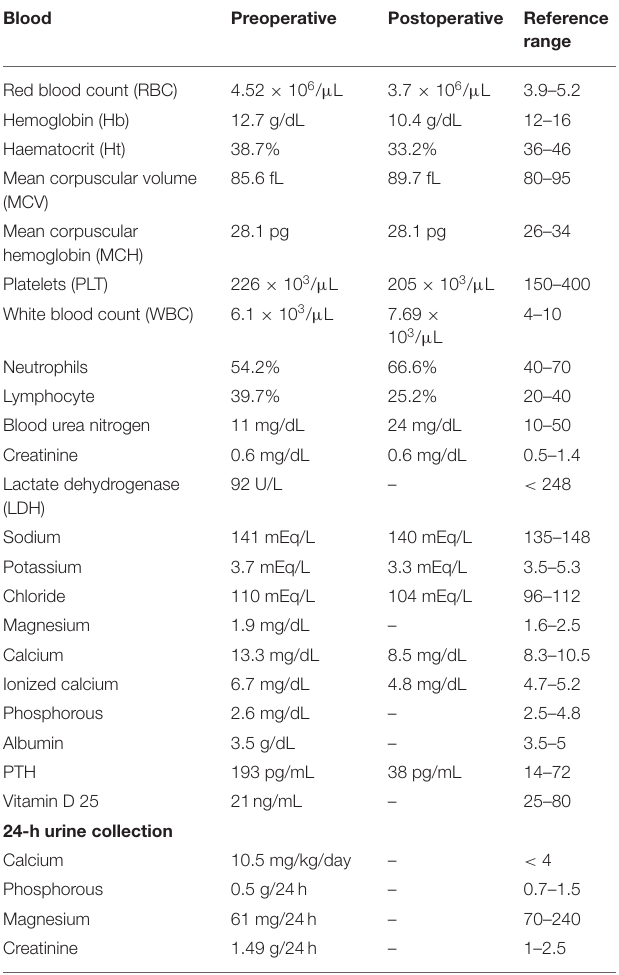
TABLE 1 | Preoperative and postoperative laboratory work-up